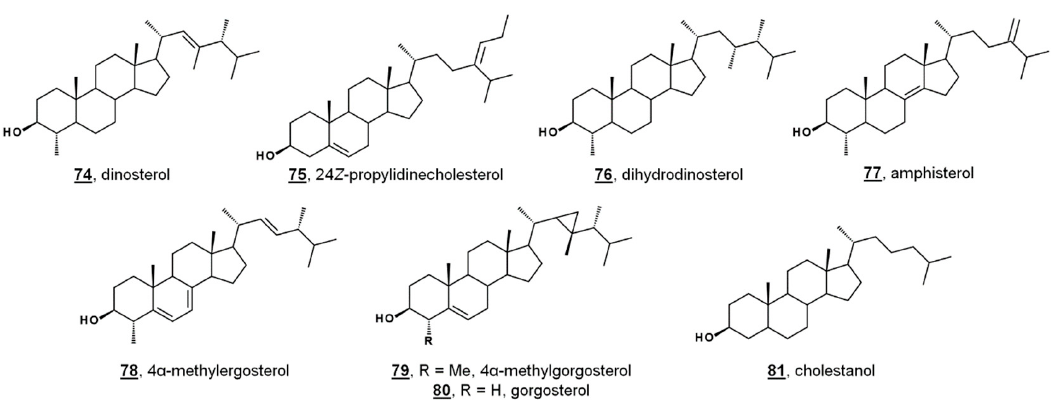
Figure 6. Sterol structures from various dinoflagellates.